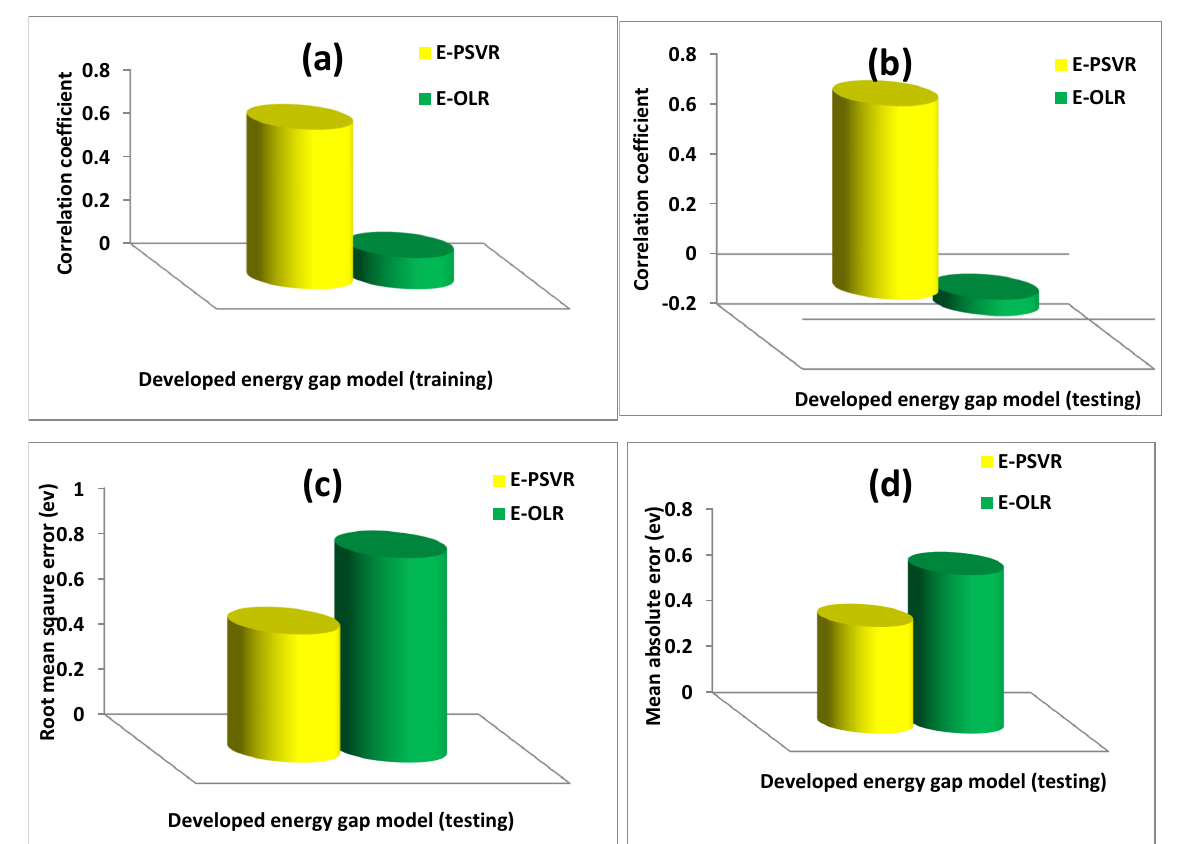
Figure 5. Performance of the developed E-PSVR model using various error metrics. ( a ) Correlation coefficient for each of the developed energy gap model during training phase ( b ) Correlation coefficient for each of the developed energy gap model during testing phase ( c ) Root mean square error for each of the developed energy gap model during training phase ( d ) Mean absolute error for each of the developed energy gap model during testing